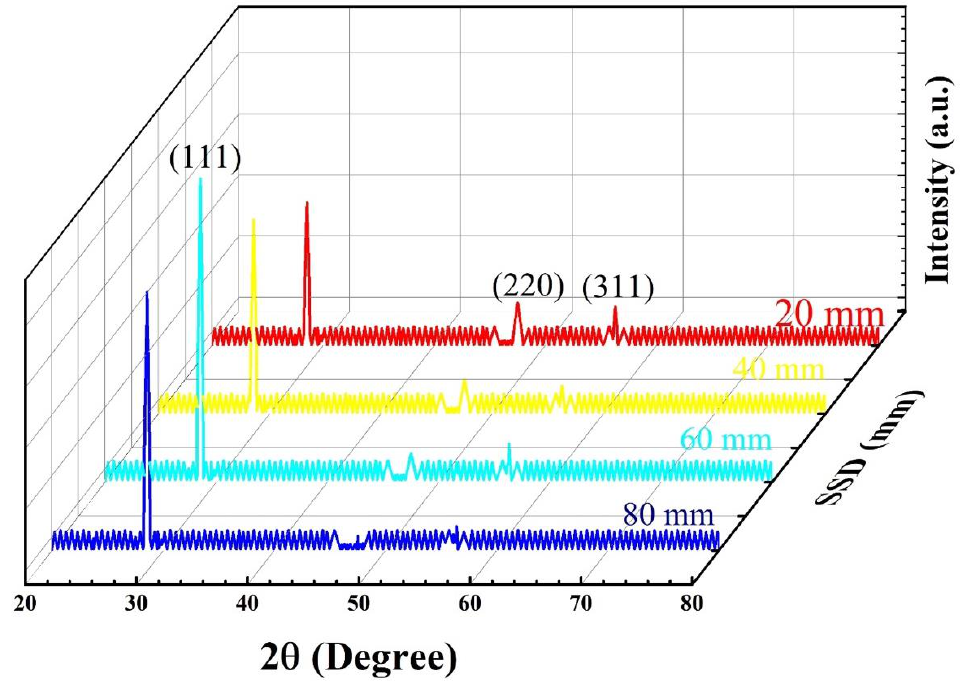
Figure 1. XRD spectrum of ZnS thin films deposited at various SSD (mm).